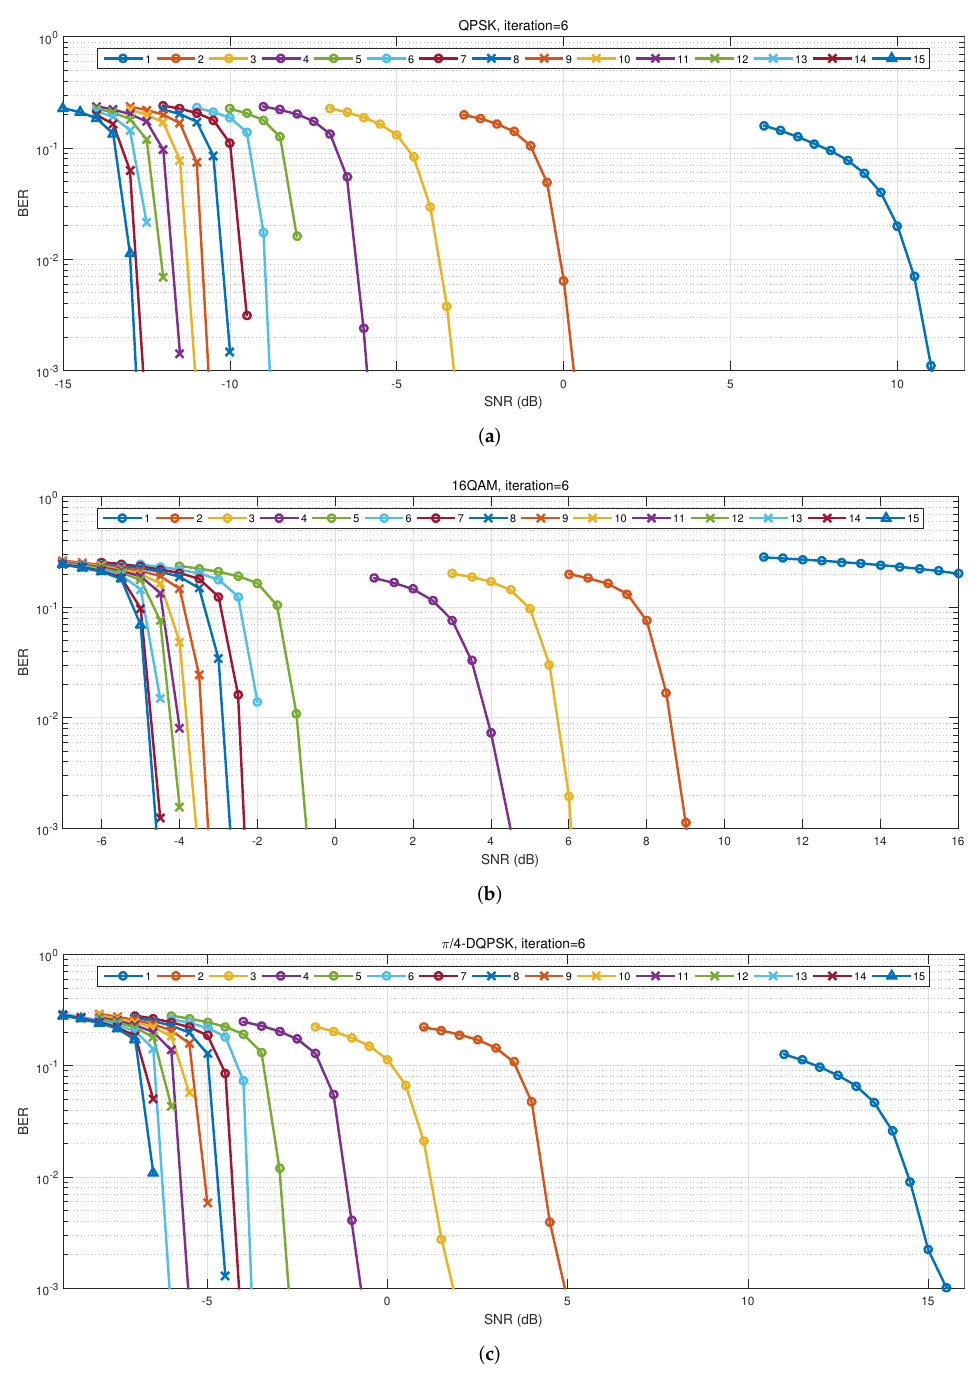
Figure 17. BER results of IoT PLC for the whole DV n : ( a ) QPSK mode; ( b ) 16QAM mode; and ( c ) π /4-DQPSK